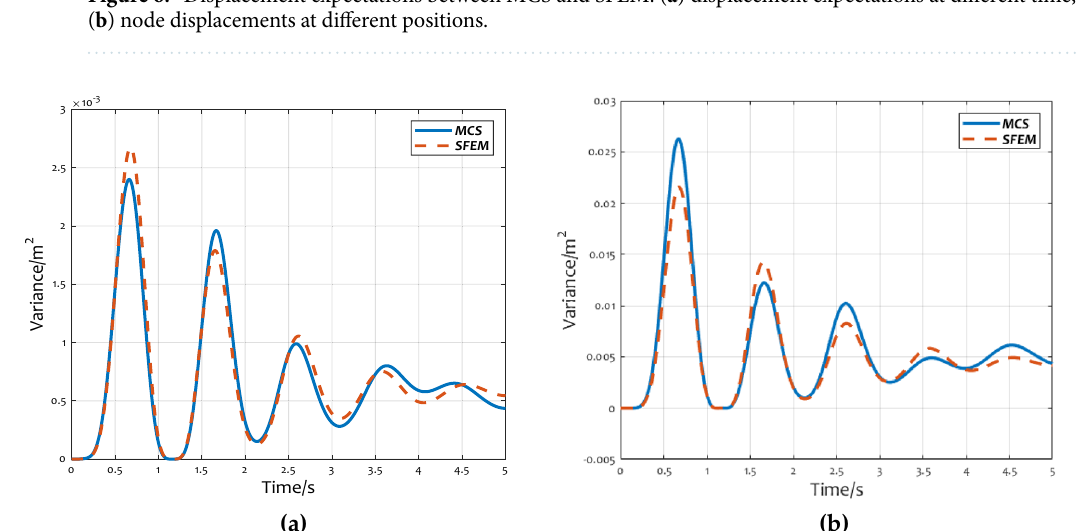
Figure 7. Comparison of displacement variance: ( a ) variance of displacement at 5 m; ( b ) variance of displacement at 10 m.